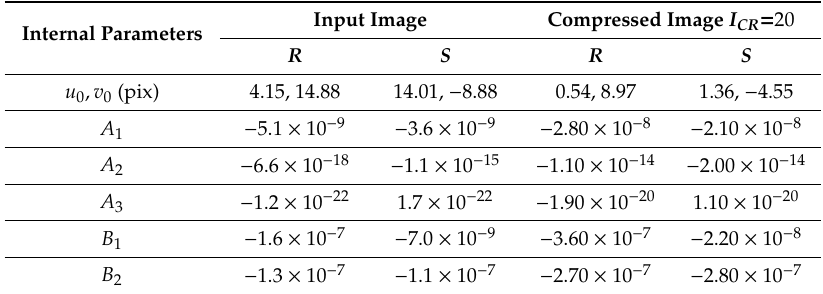
Figure 12. Quasi-static test setup used for experimental validation of image compression along with the vision-based sensor components and optical targets details. Table 6. Results of photogrammetry using input (original) image size and compressed images.